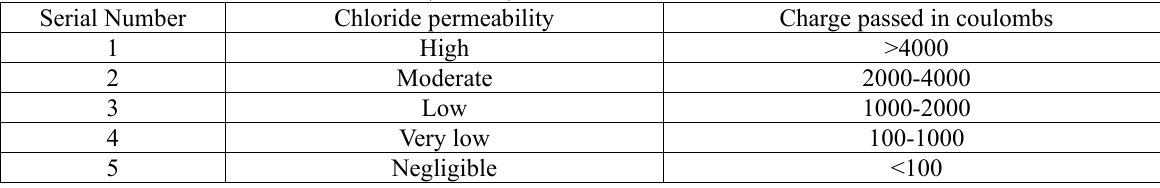
Chloride diffusion assessment criteria